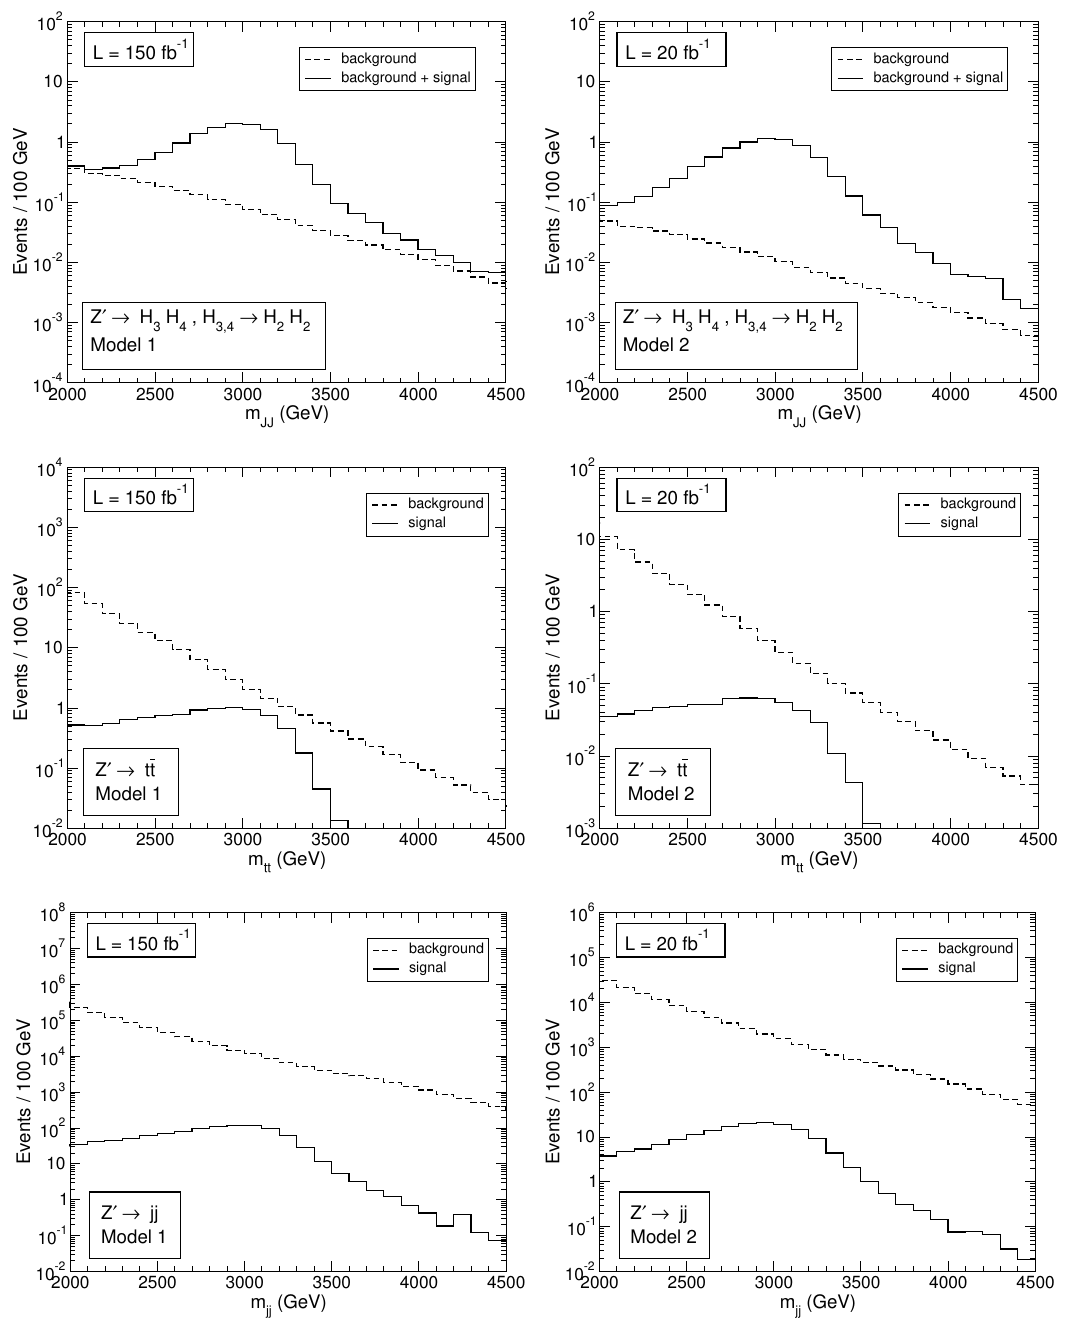
Figure 6 . Invariant mass distribution for the Z 0 signals in scenario 2 and their backgrounds, in the generic (top), t (cid:22) t (middle) and dijet (bottom) analyses, for model 1 (left) and model 2